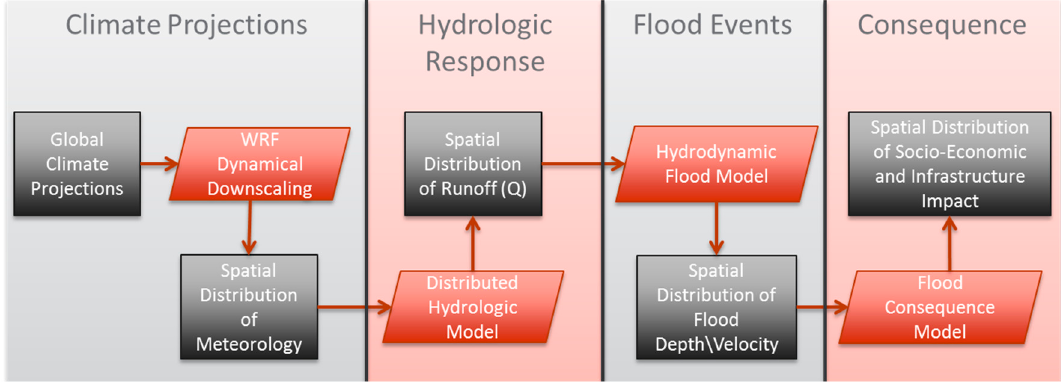
Figure 1. The integrated multi-scale, multi-model framework for flood risk estimation.